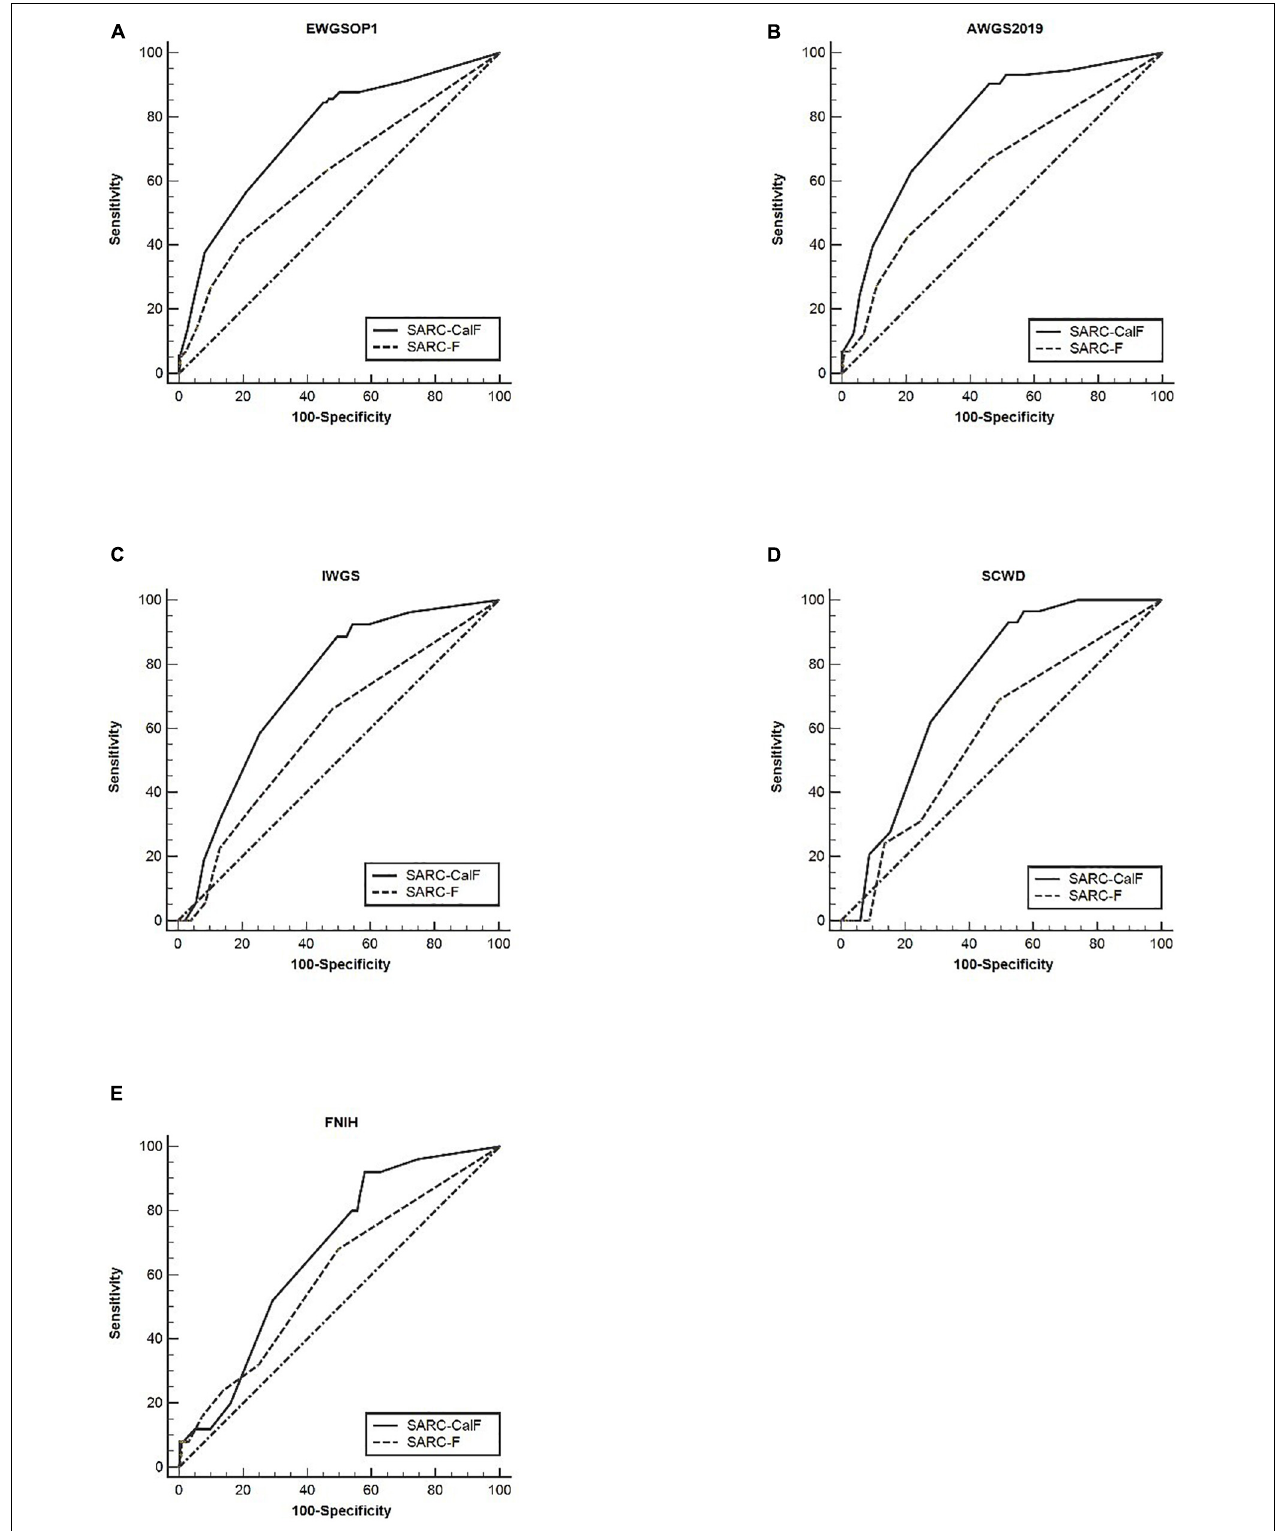
FIGURE 4 | The ROC curves of SARC-F and SARC-CalF compared with various reference norms in the older group: (A) sarcopenia according to the EWGSOP1 criteria; (B) sarcopenia according to AWGS2019 criteria; (C) sarcopenia according to IWGS criteria; (D) sarcopenia according to SCWD criteria; and (E) sarcopenia according to FNIH